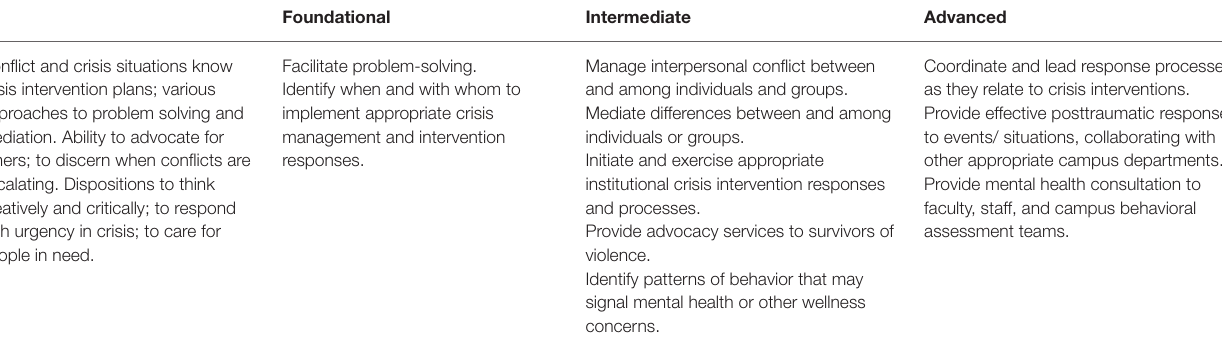
TABLE 1 | Conflict and crisis situations